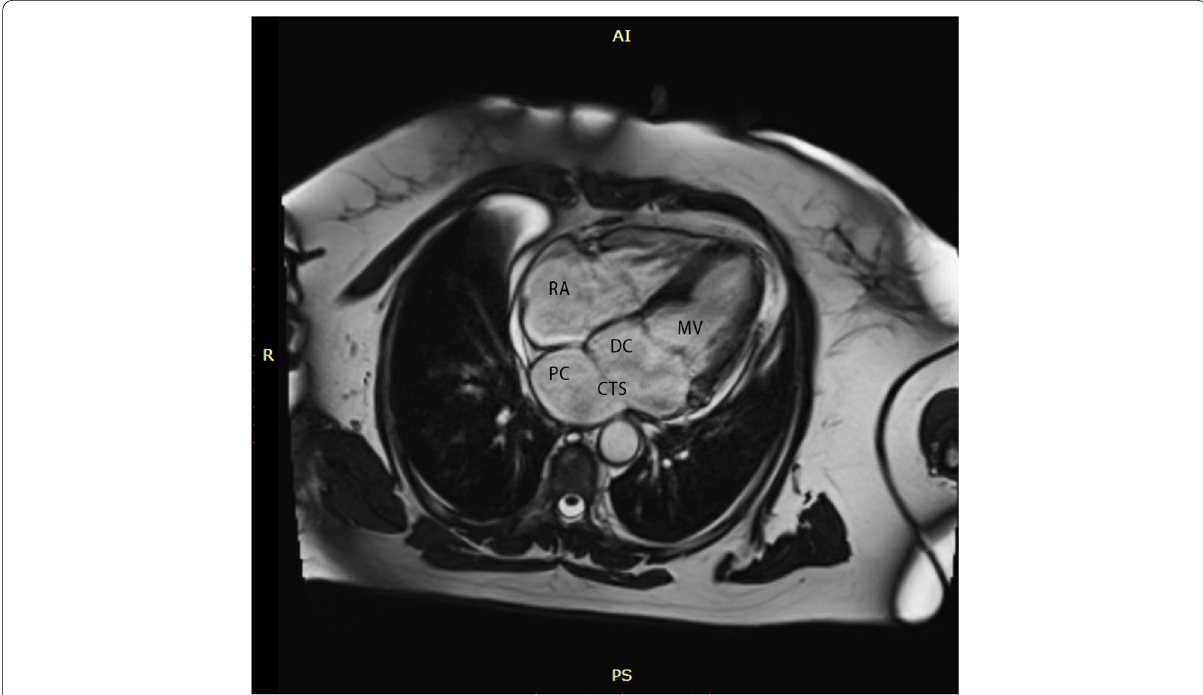
Fig. 1 Apical 4-chamber on magnetic resonance. RA: right atrium; MV: mitral valve; CTS: cor triatriatum sinister; PC: proximal chamber of left atrium; DC: distal chamber of left atrium (see text for